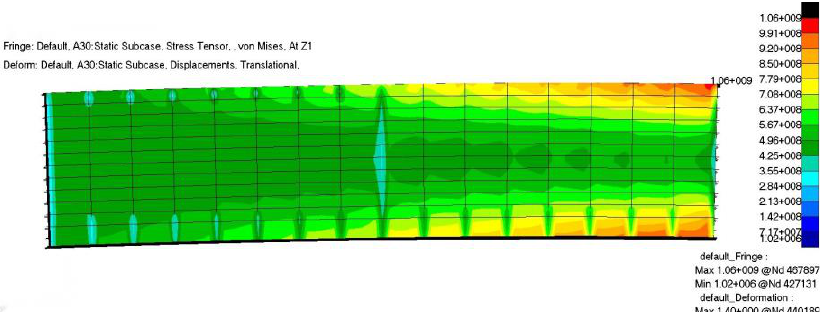
Figure 28. Stress cloud diagram of cabins 4 and 5 at the time of the accident.